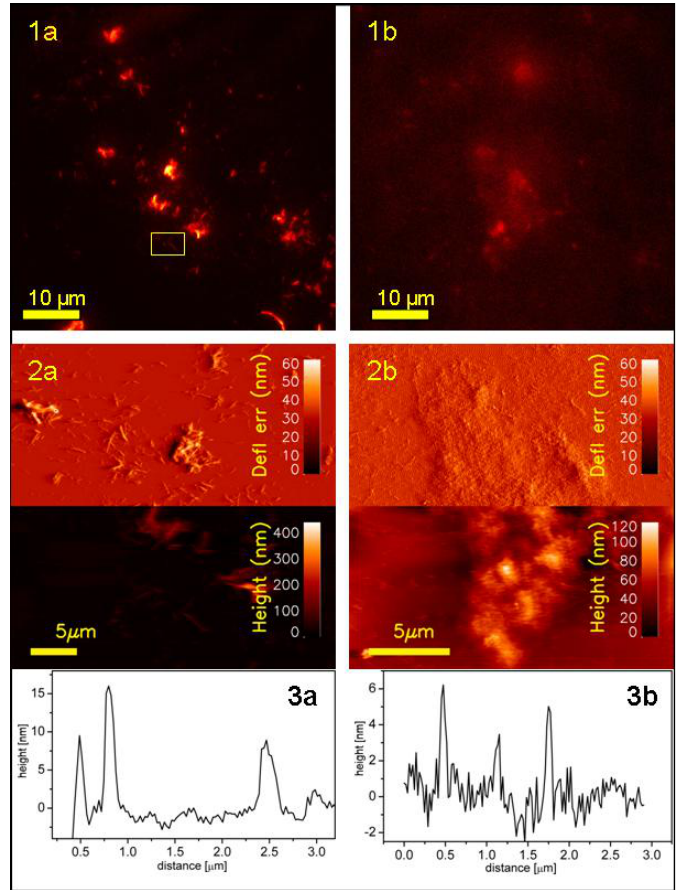
Figure 7. Characteristic images of single insulin amyloids–fibrils (panel a) and filaments (panel b): TIRFM fluorescence signal from h -HTAA-labeled fibrils ( 1a ), and p -FTAA-labeled filaments ( 1b ). Colocalized structural topography: contact mode AFM images (lower part, height; upper part, deflection error) for fibrils ( 2a ) and filaments ( 2b ). Plots ( 3a ) and ( 3b ) show height profiles from height images ( 2a ) and ( 2b ), respectively. Frame on image 1a depicts an area that was chosen for further zooming (see Figure 8 for